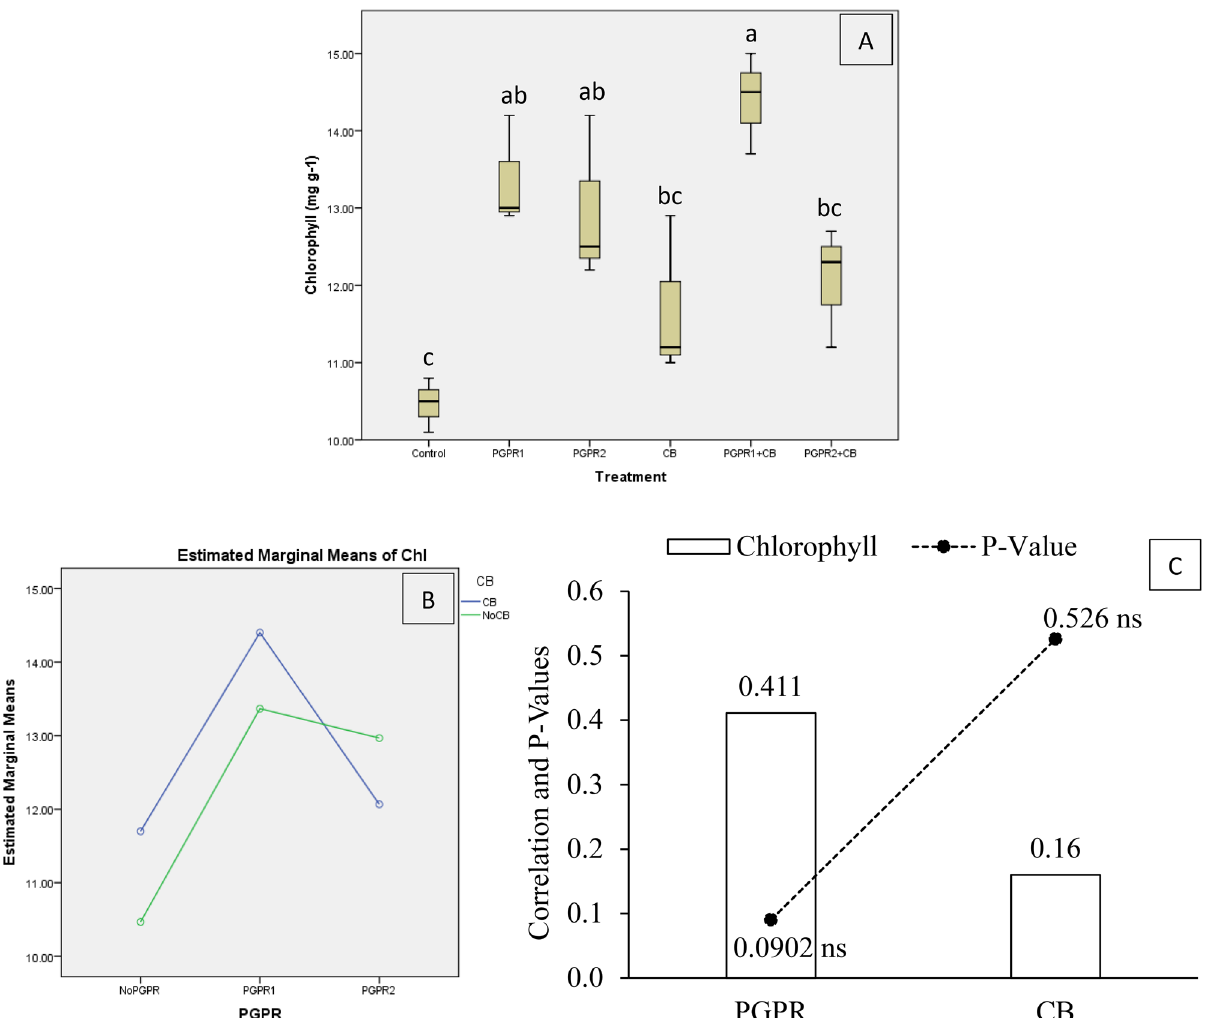
Figure 11. Effect of treatments on mint plants leaves chlorophyll contents. Values are the average of three replicates ( A ). Different letters showed significant differences (Tukey’s test; p ≤ 0.05). Interaction graph of PGPR and CB for Chl ( B ). Correlation graph of PGPR and CB for Chl ( C